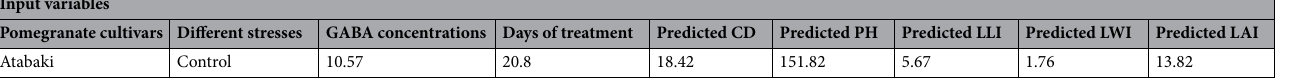
Table 3. Optimizing the concentration of GABA, days of treatment, pomegranate cultivars and salinity- drought stress according to the MLP-NSGA-II for obtaining the best pomegranate morphological traits.